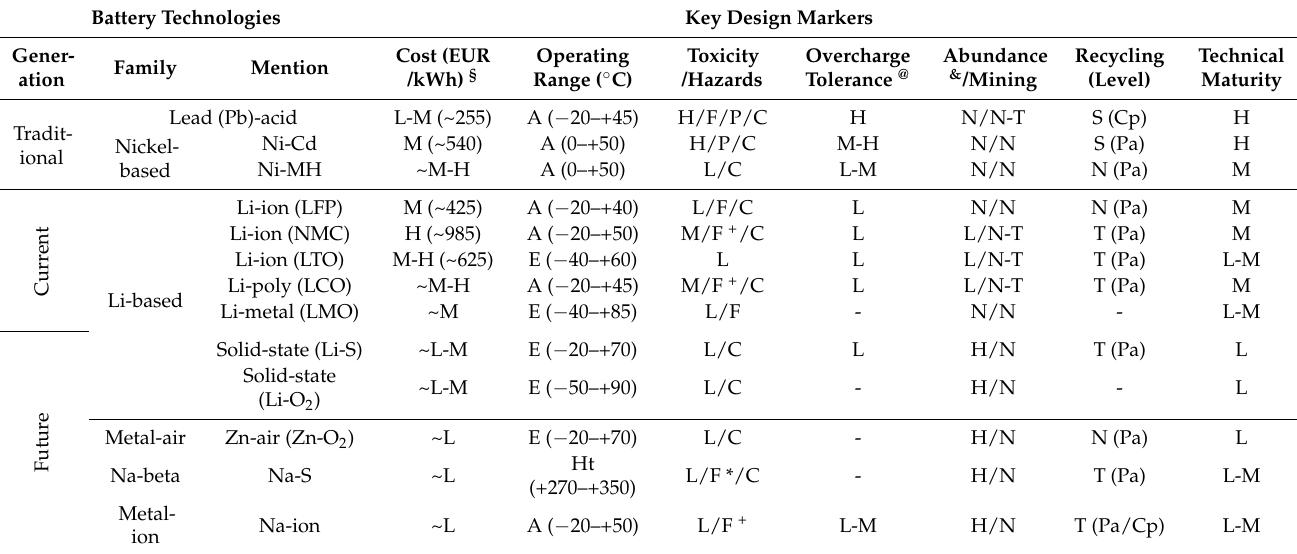
Table 2. Comparison: key design markers of battery technologies. Key Design